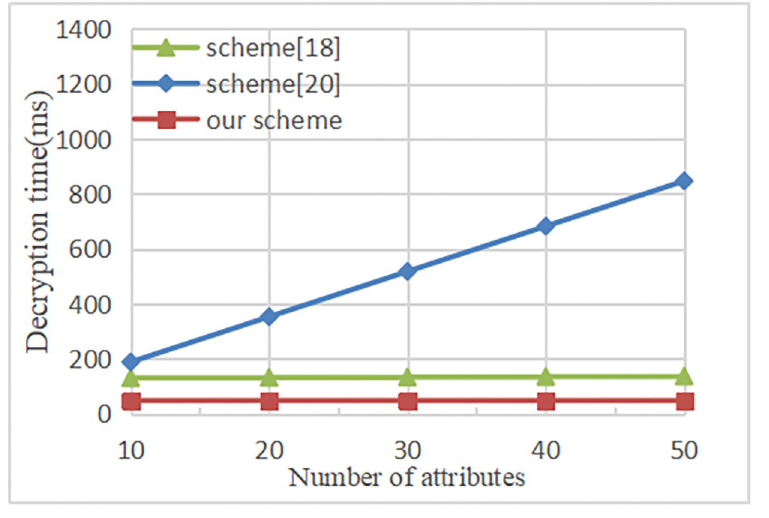
Fig 5. Time cost in